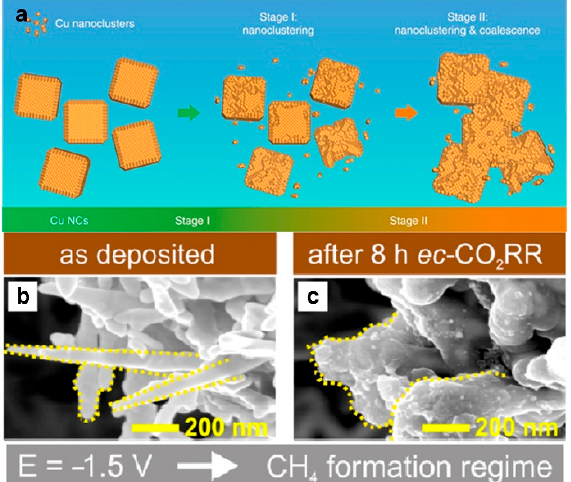
Figure 10. Catalyst restructuring: ( a ) schematic restructuring mechanism of the CuNC catalyst during the CO 2 RR, including nanoclustering (stage I) followed by coalescence (stage II) (reproduced with permission from ref. [74], copyright 2018, Springer Nature); ( b , c ) SEM images of the same location on an Ag-foam catalyst ( b ) before, and ( c ) after the electrochemical CO 2 RR at − 1.5 V vs. RHE, showing restructuring of the catalyst (reproduced with permission from ref. [55], copyright 2018, ACS).